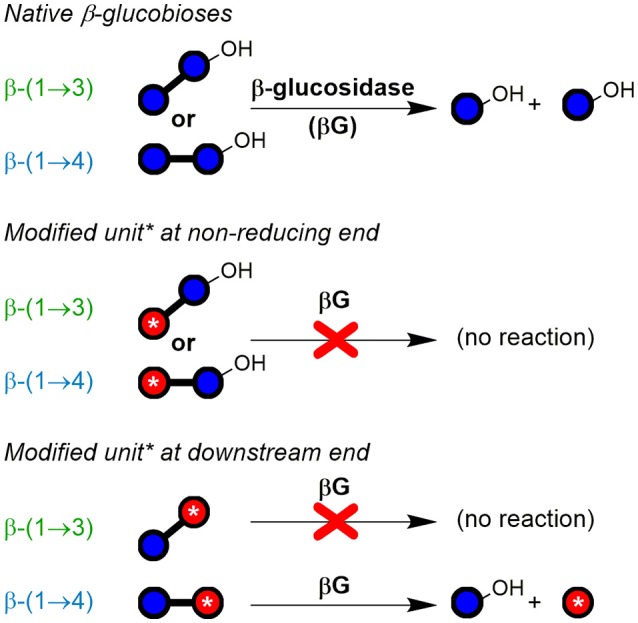
Susceptibility of native and modified β-glucobioses to hydrolysis by the used exo-β-glucosidase (from Aspergillus niger; EC 3.2.1.21; GH family 3). The enzyme was observed to cleave off native β-(1→3)- and β-(1→4)-linked non-reducing end glucosyl units, unless they are β-(1→3)-linked to certain types of modified units (red ○ with *), especially if containing CO2H or labeled functional groups. Blue ○, glucose unit; blue ○–OH, reducing end glucose unit.